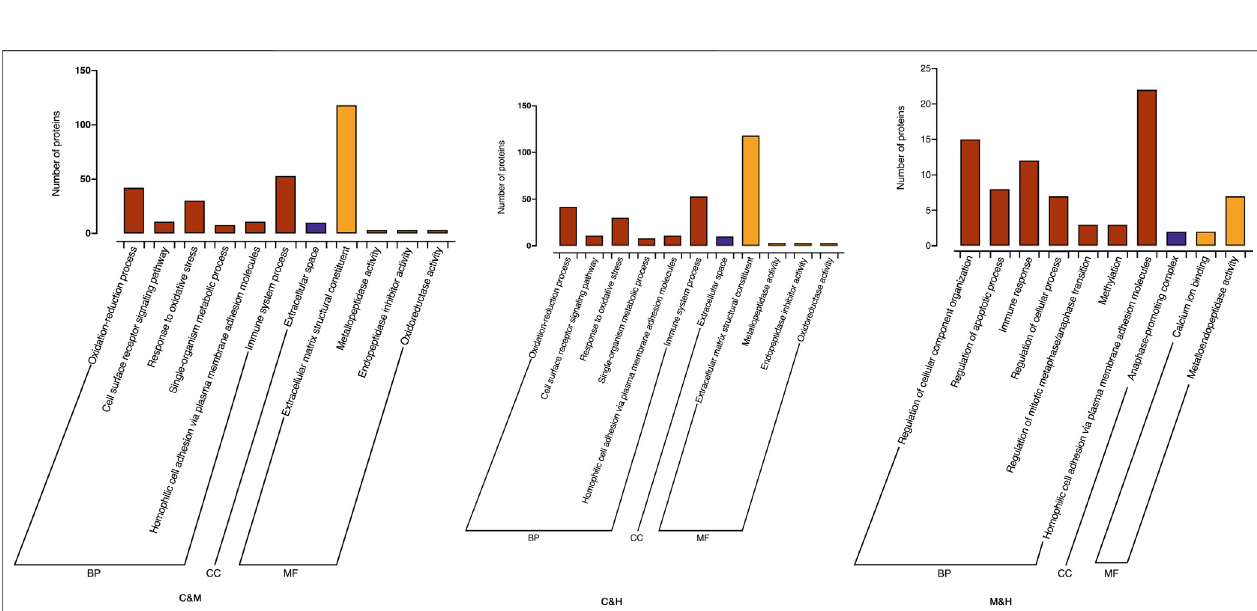
FIGURE 7 | GO enrichment histogram, each presenting TOP20 (Adjusted p v < 0.05, n = 3). C: normal control; M: model control; H: HQT control.